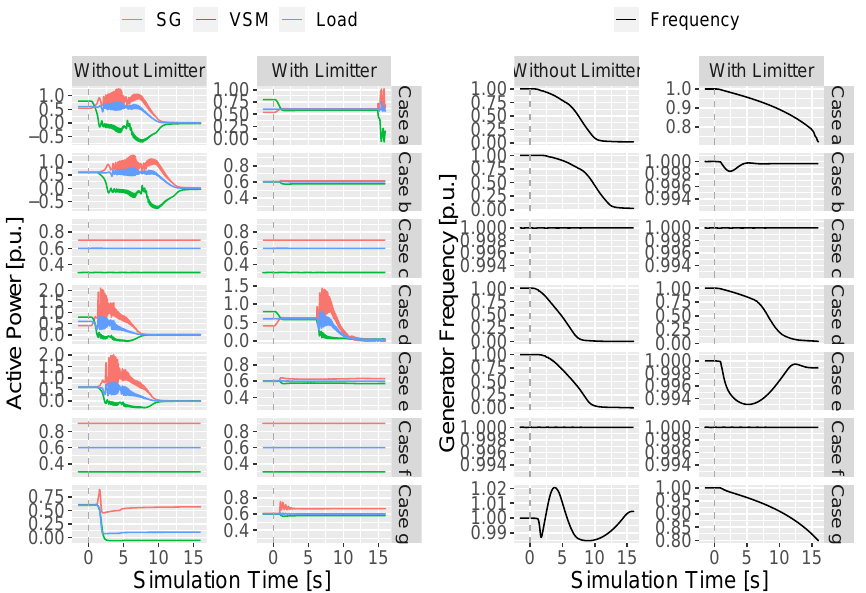
Without Limitter With Limitter